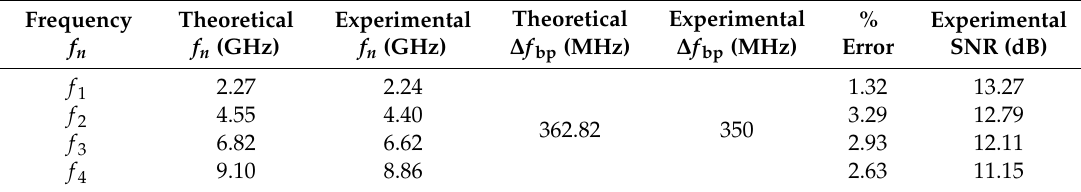
Table 2. Electrical characteristics of the filtered band-pass windows.